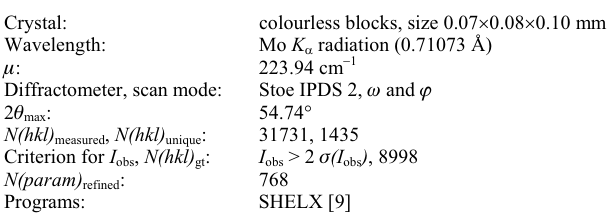
Table 1. Data collection and handling.